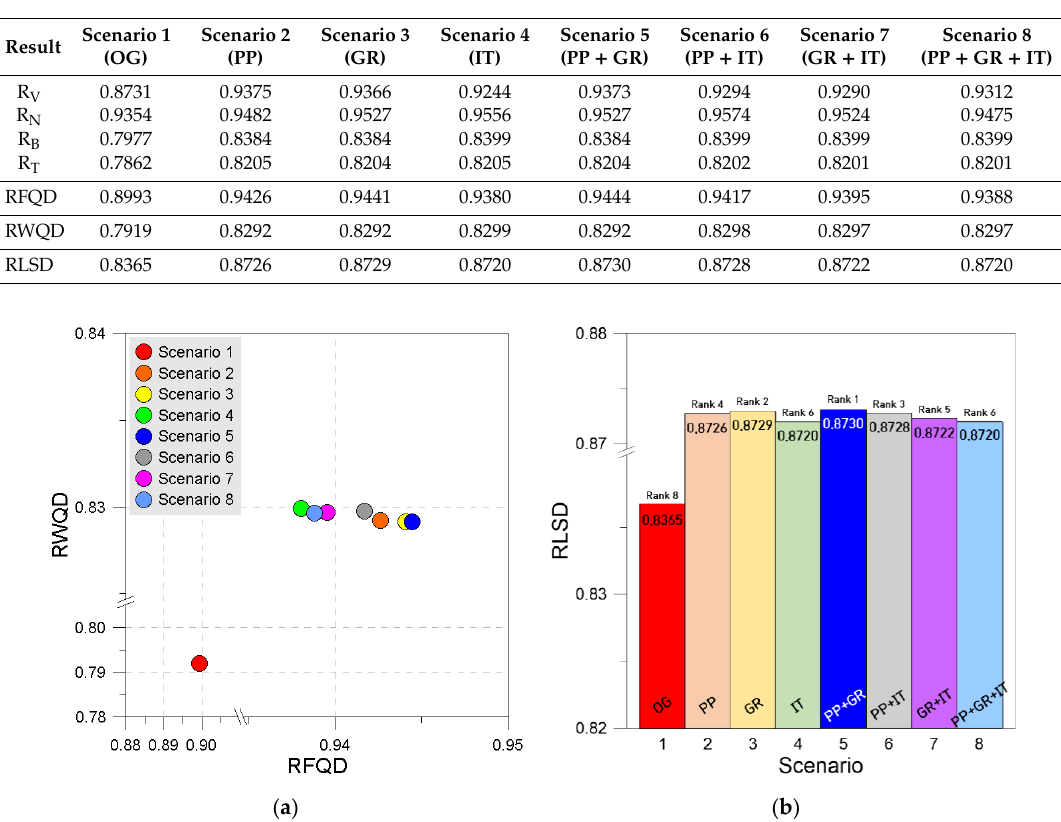
Table 10. Result of reliability index based on LID scenarios.